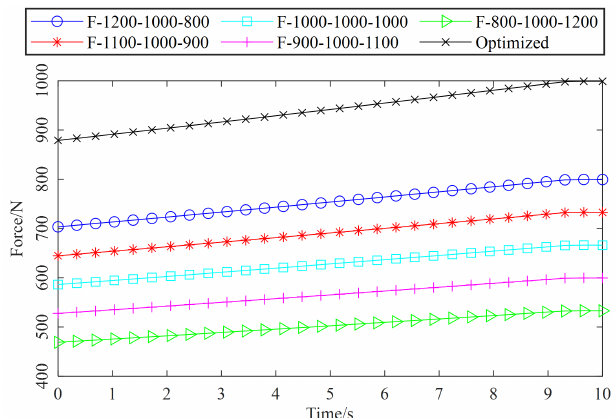
Figure 9. Comparison of the maximum reachable horizontal forces obtained by different distributions of the unit actuating forces along the same given trajectory. (‘F’ denotes ‘actuating forces’, and the numbers after F represent the force constraints of each unit. For example, ‘F-1200-1000-800’ represents that the actuating force ranges of the 1st, 2nd, and 3rd units are respectively − 1200 ∼ 1200, − 1000 ∼ 1000, and − 800 ∼ 800